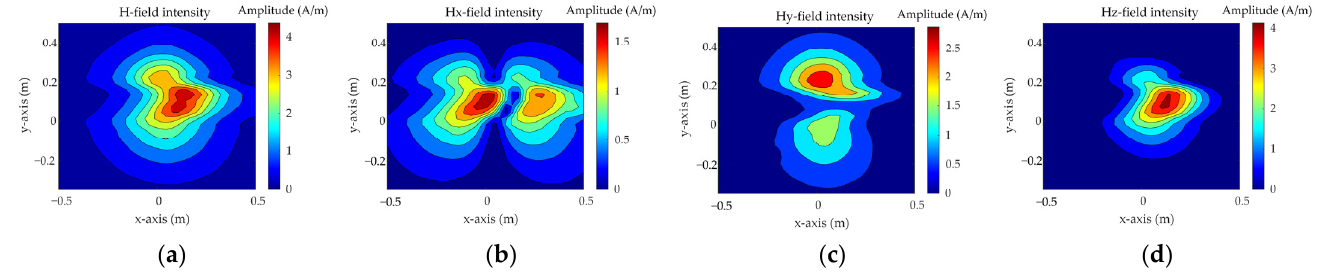
Figure 6. The distribution of magnetic field intensity at 12.5 cm away from the radiation source. ( a ) The amplitude distribution of H; ( b ) The amplitude distribution of Hx; ( c ) The amplitude distribu- tion of Hy; ( d ) The amplitude distribution of Hz.